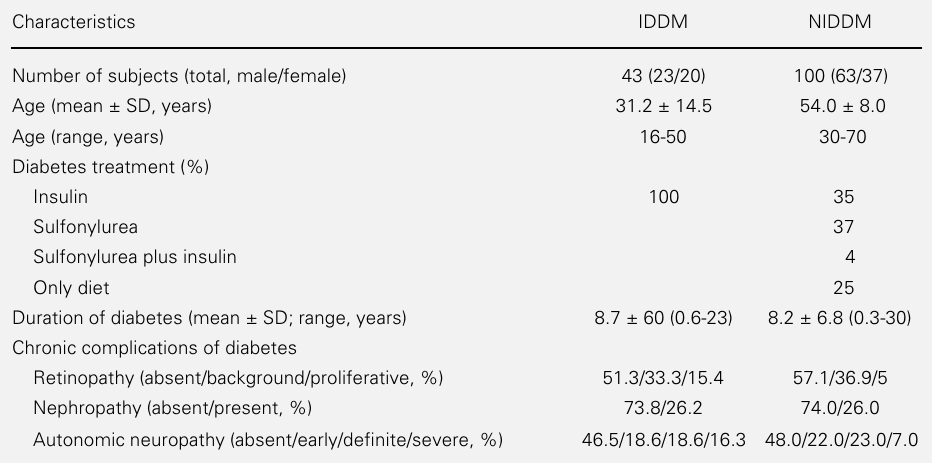
Table 1 - Clinical characteristics of diabetic patients.